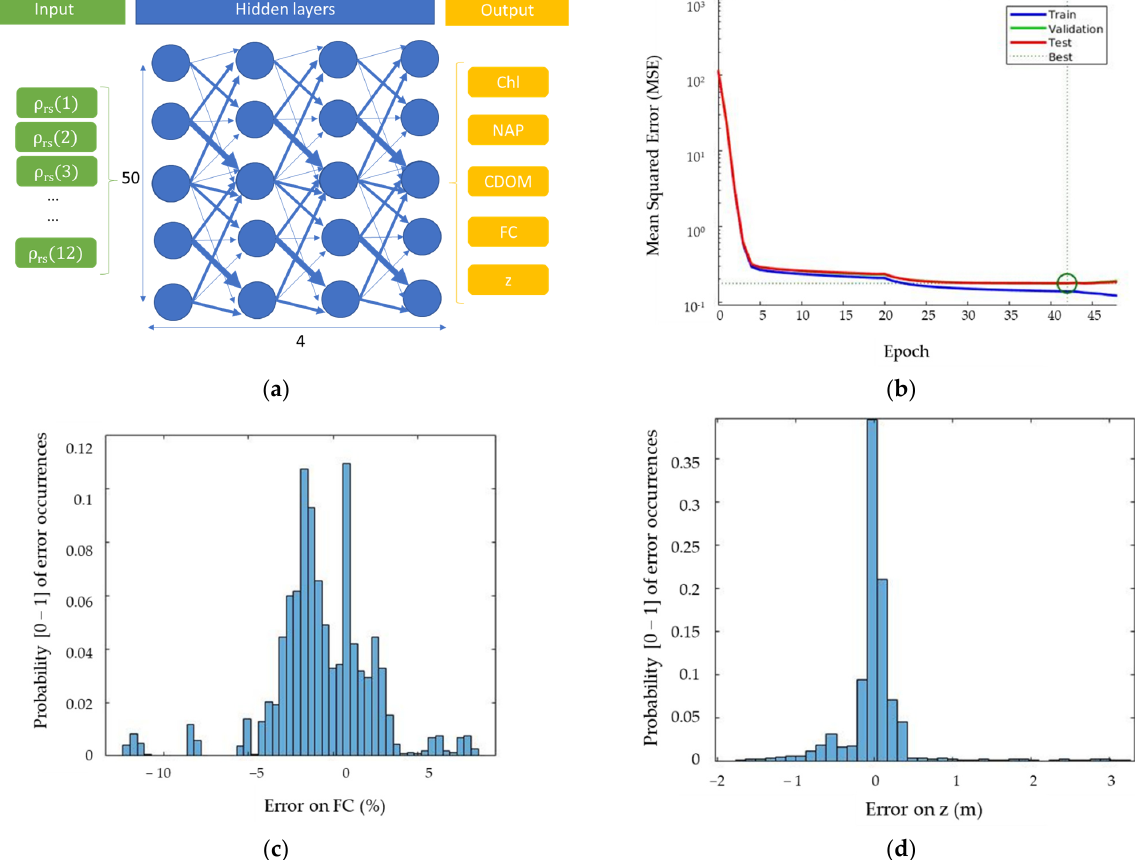
Figure 10. ( a ) Neural Network Architecture; ( b ) MSE per epoch for the training phase (blue), validation phase (green) and test phase (red); the histogram of the probability of the error (validation phase) ( c ) for FC component and ( d ) for z component.